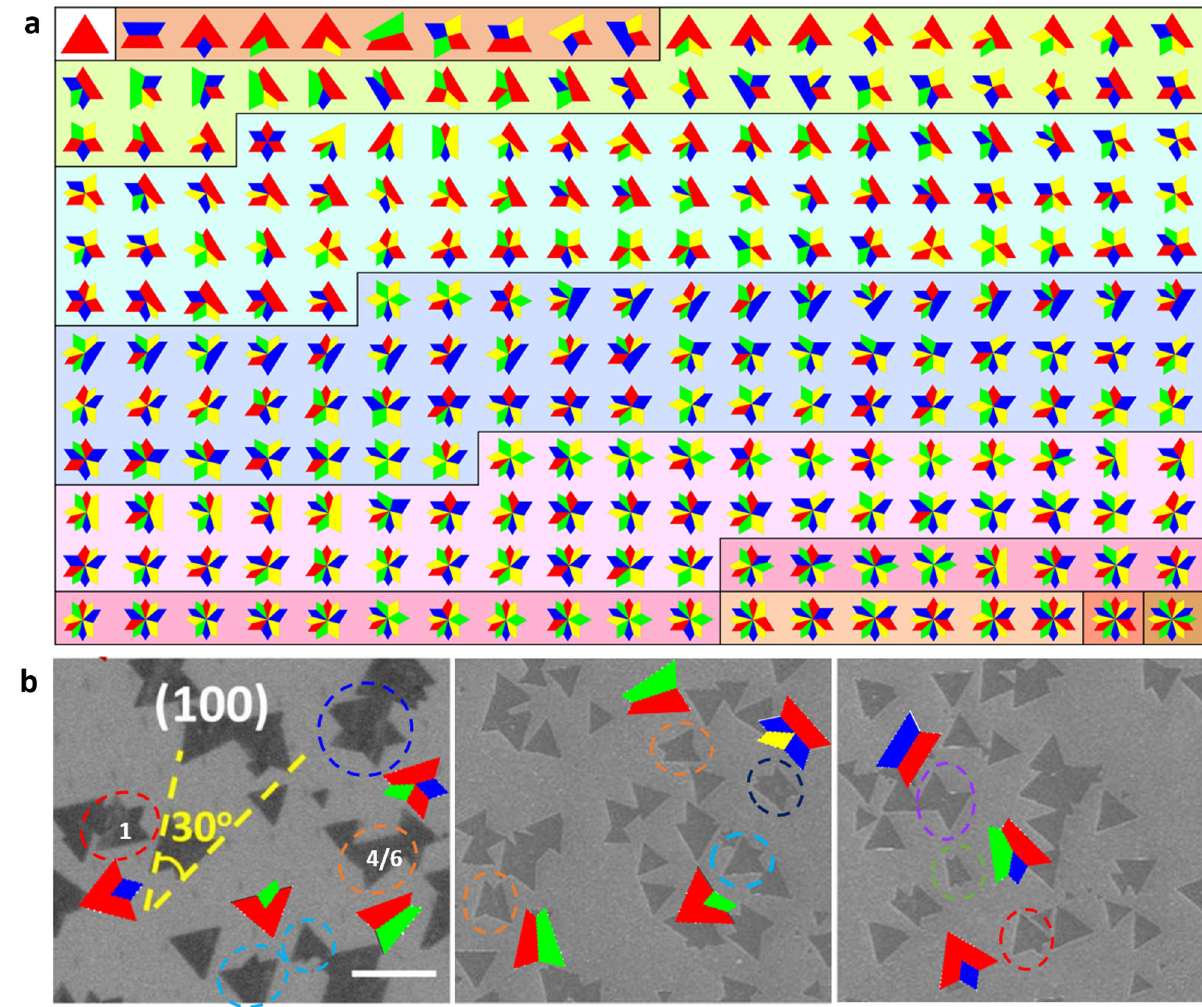
Fig. 6 Structures of polycrystals in family-III/IV. a The library of polycrystals in family-III/IV. The polycrystals are classi fi ed by their number of convex vertices. b SEM images of CVD grown hBN on Cu(100) surfaces. Polycrystalline hBN grains of different types are highlighted by dashed circles with different colors. The corresponding theoretical models are added near these polycrystalline hBN islands. Left panel, copyright from ref. 44 . Middle and right panels, reprinted with permission from ref. 17 , Copyright 2019 Springer